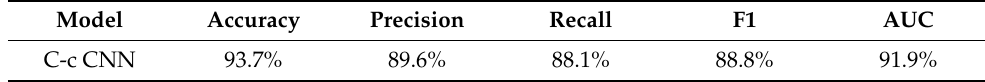
Table 4. Results of the classification